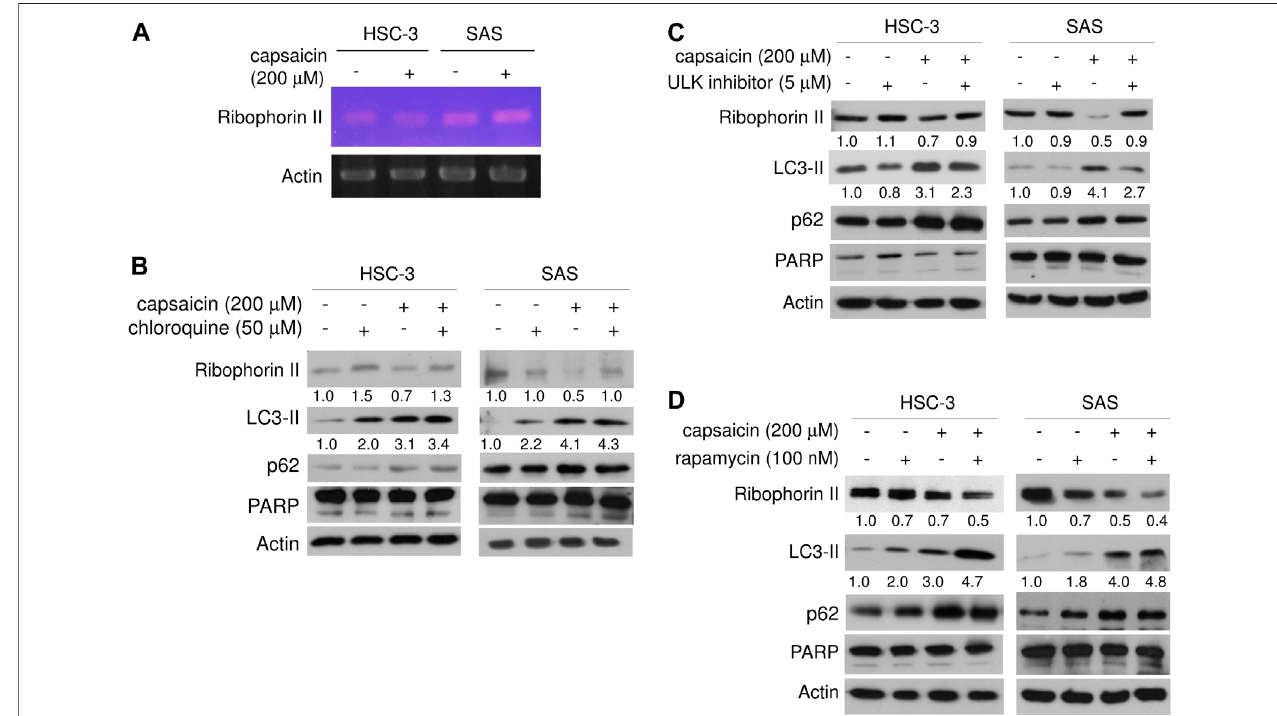
FIGURE 3 | Capsaicin induces autophagy, which down-regulates ribophorin II. (A) After capsaicin treatment for 24 h, mRNA levels of ribophorin II in HSC-3 and SAS cells were assayed by RT-PCR. (B) Cells were pre-treated with capsaicin for 42 h, co-treated with chloroquine for another 6 h, and then Western blot assays were used to examine the levels of ribophorin II, LC3-II, p62, and cleaved PARP. (C) Cells were pre-treated with capsaicin for 42 h, co-treated with ULK1 inhibitor for another 6 h, and then evaluated with Western blot assays. (D) Cells were pre-treated with capsaicin for 24 h, co-treated with rapamycin for another 24 h, and then evaluated with Western blot assays. Data are representative of fi ve to six independent